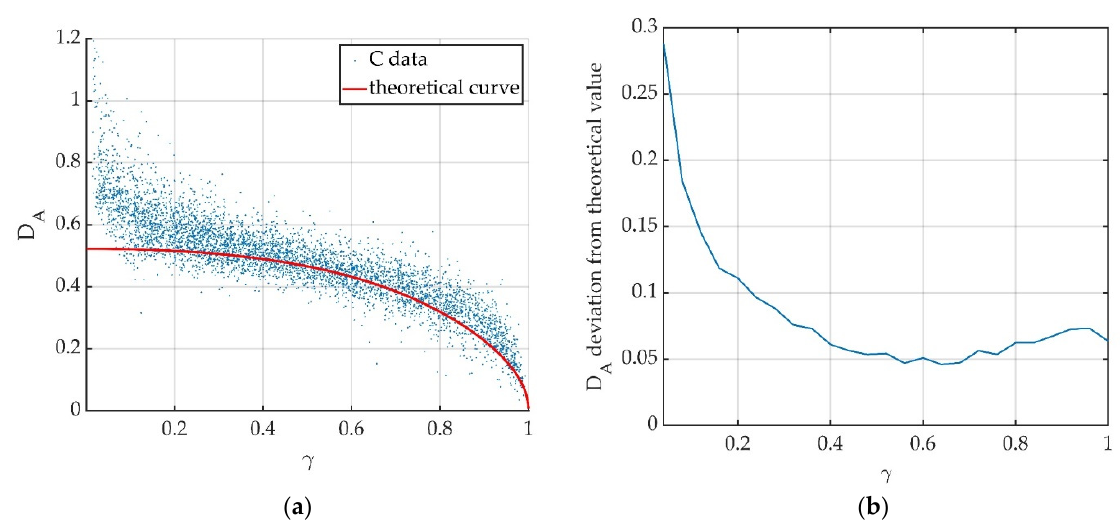
Figure 8. Results obtained for C-band data. ( a ) Relation between amplitude dispersion index D A and coherence γ of experimental data compared to the theoretical red curve, Equation (14). Each dot represents a resolution cell in the analyzed area. ( b ) Deviation of experimental D A values from theoretical ones.